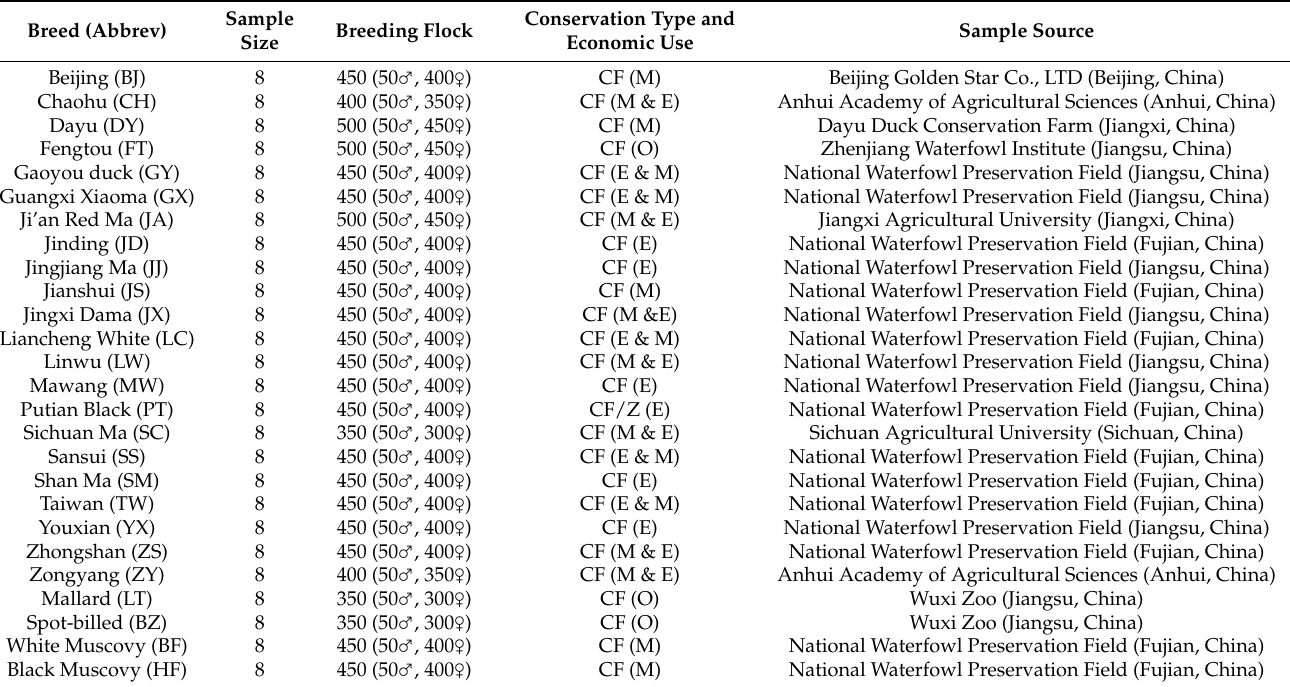
Table 1. Characteristics of the 26 duck populations.